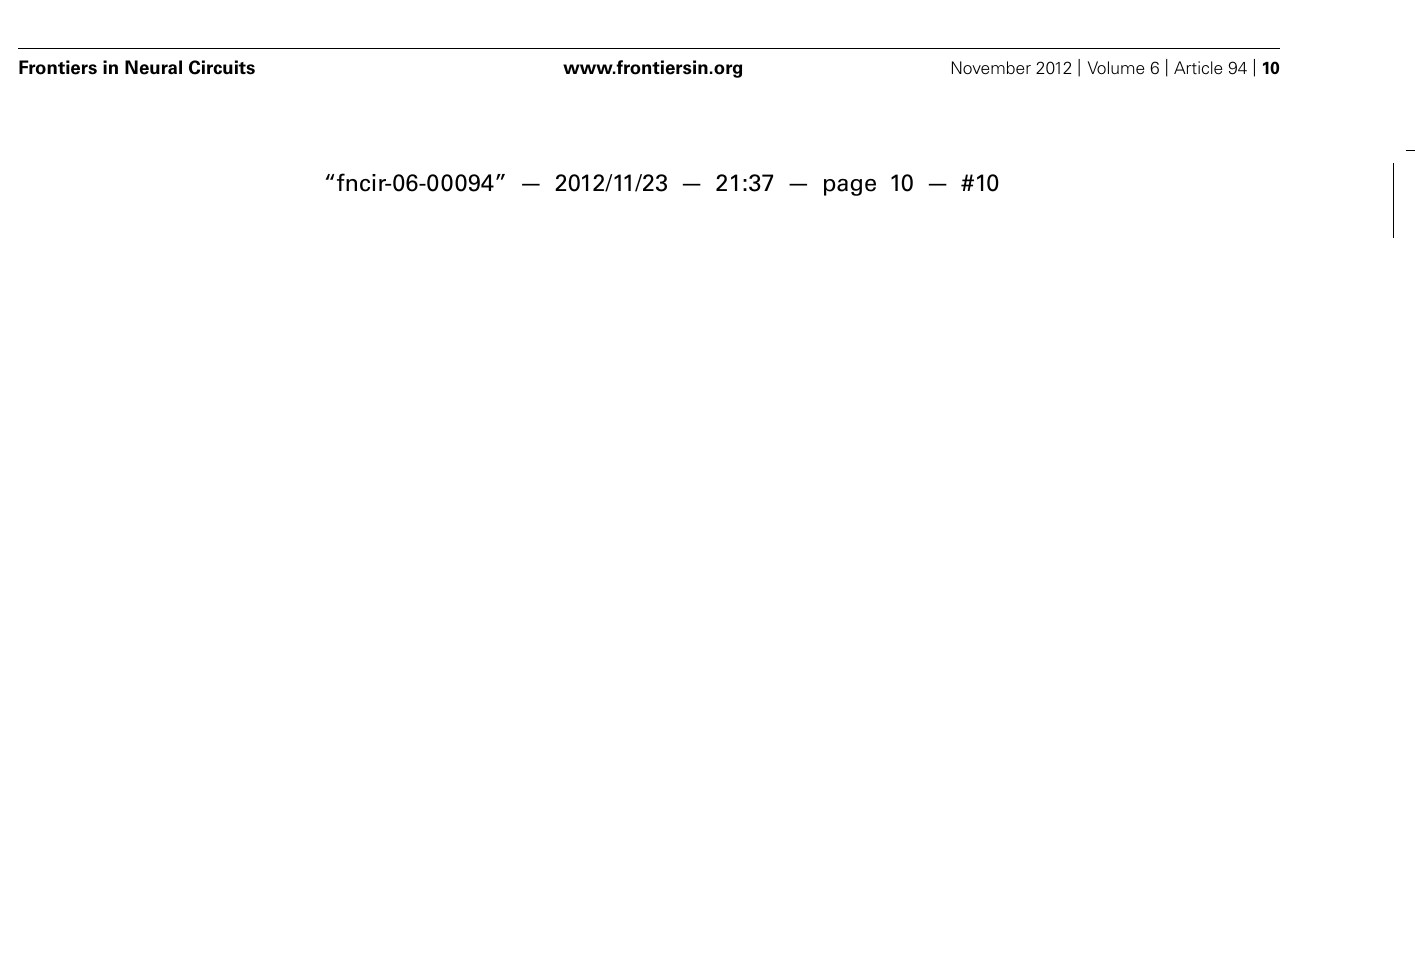
respective PO of each state. Notice that state 2 values are ∼ 2/3 of state 1 values in the excitatory cluster. (C,E) Excitability and number of engaged neurons for the inhibitory cluster in the state 1 (open square) and 2 (closed circles). Notice that state 2 values are ∼ ½ of the state 1 values in inhibitory cluster. Data segments from controls and wash-out had durations and number of bursts (in parenthesis) of 30 min ( ∼ 120) and the ALLO segments had durations of 10 min ( ∼ 40). At 3 μ M ALLO only seven bursts were